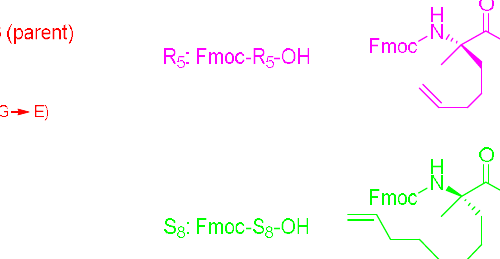
Figure 9. BID-BH3 parent peptide and the corresponding five analogs with different stapling positions. Nor: Norleucine. Fmoc-R 5 -OH (Fmoc-(R)-2-(4-pentenyl)Ala-OH) and Fmoc-S 8 -OH (Fmoc-(S)-2-(7-octenyl)Ala-OH) are shown at the right in pink and green, respectively. For S 5 refer to the legend of Figure 6.